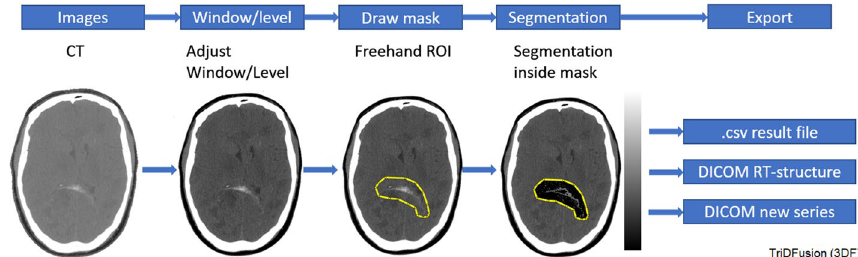
Fig. 9 The workflow to isolate blood from the surrounding tissue. The sequential steps for blood pool segmentation are shown from left to right. The yellow border indicates the constraint, and the isolated voxels are depicted on the right. CT, computed tomography; ROI, region of interest